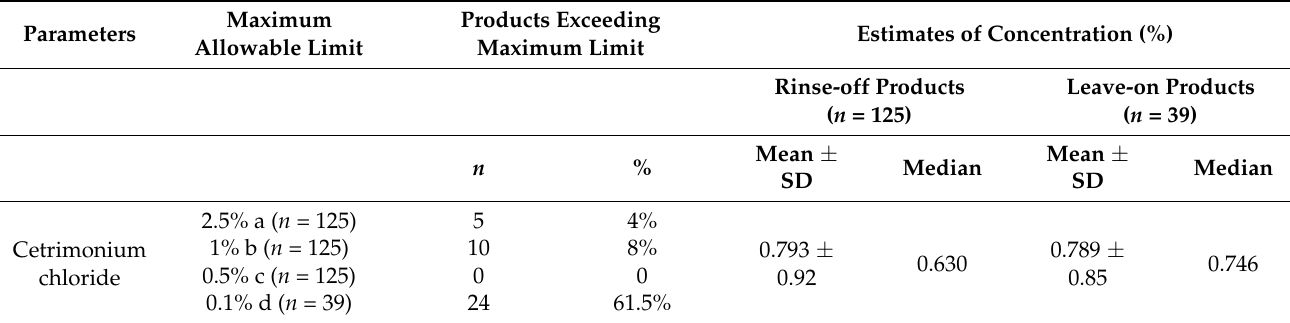
Table 2. Estimates of Cetrimonium chloride content from cosmetics and personal care products and Maximum Allowable Limit ( n =